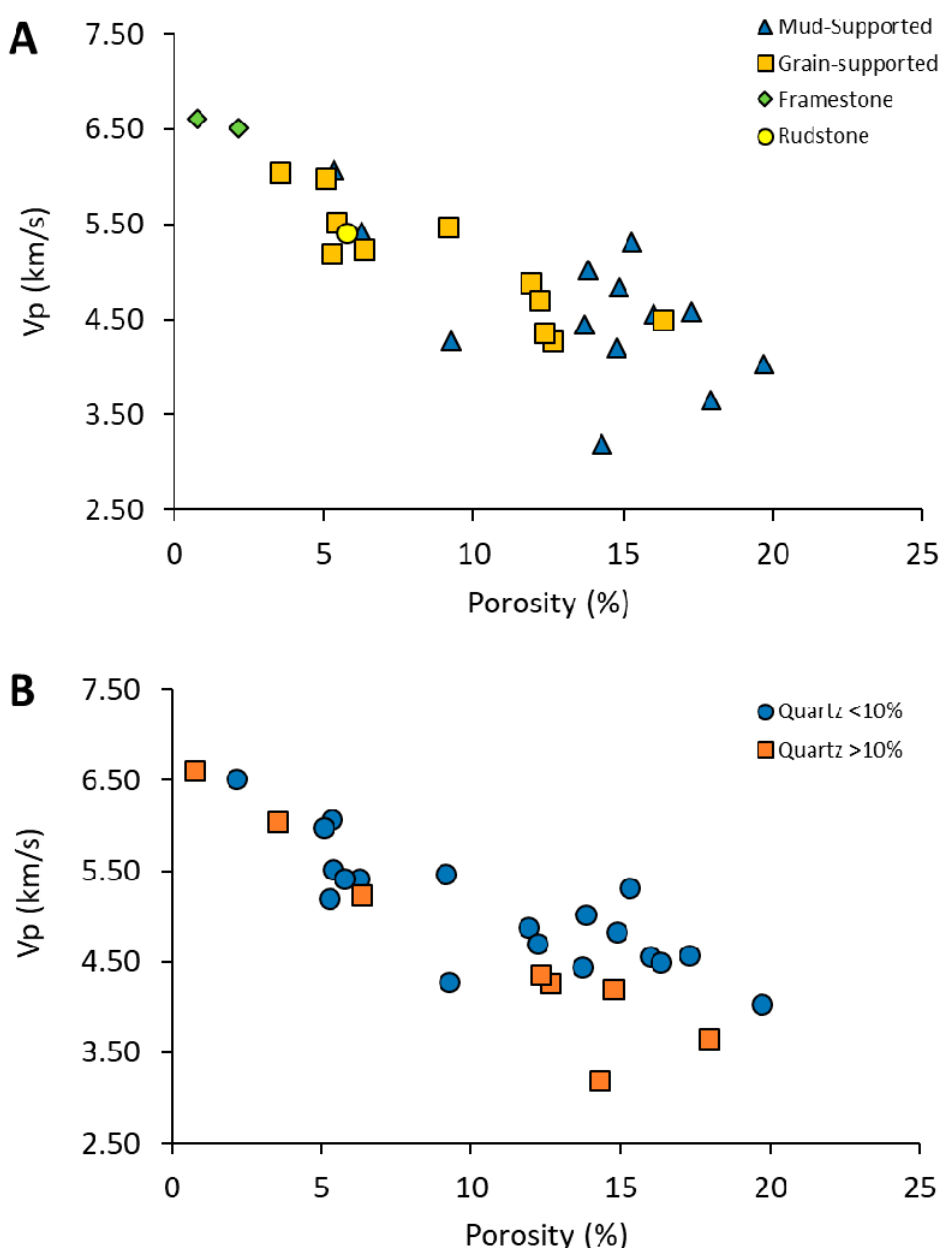
Figure 11. ( A ) V P –porosity relation with depositional texture superimposed. Majority of the mud-dominated samples (mudstone and wackestone) have higher porosity and permeability values with relatively lower velocities (below 5 km/s). ( B ) V P –porosity relation with quartz content superimposed. Quartz-rich samples have lower velocities than quartz-poor samples.